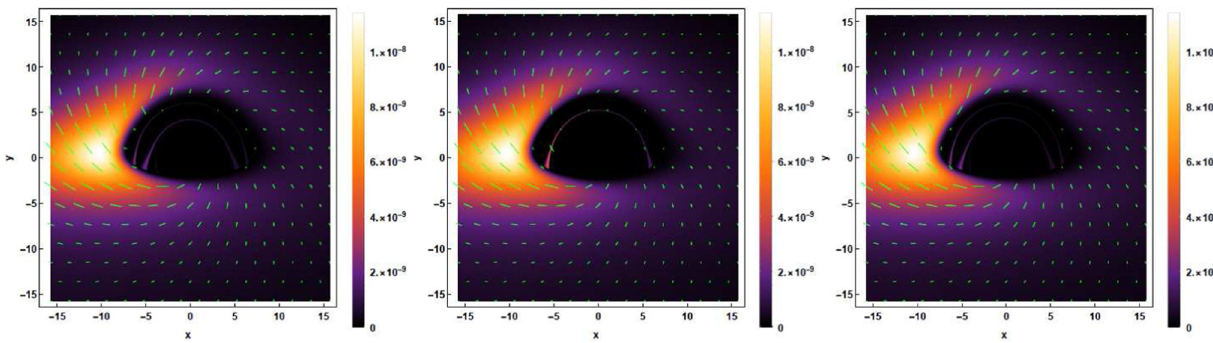
Fig. 9 Polarized intensity tick plots in the image for the fixed θ o = 70 ◦ . The coupling parameter α in three panels from left to right is set to − 0 . 4, 0, and 0 . 4, respectively. Here, we set M = 1